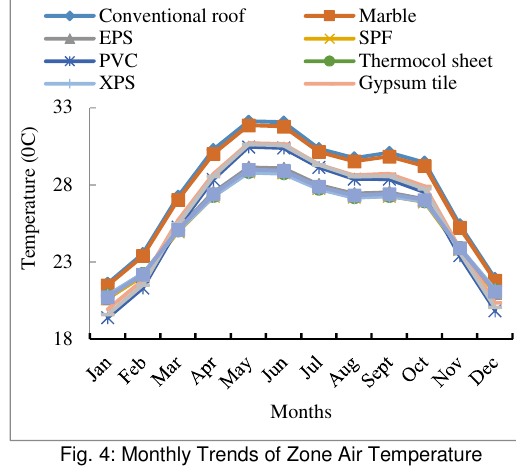
Fig. 4: Monthly Trends of Zone Air Temperature Table 5: Roof's Outside and Inside Surface Temperature